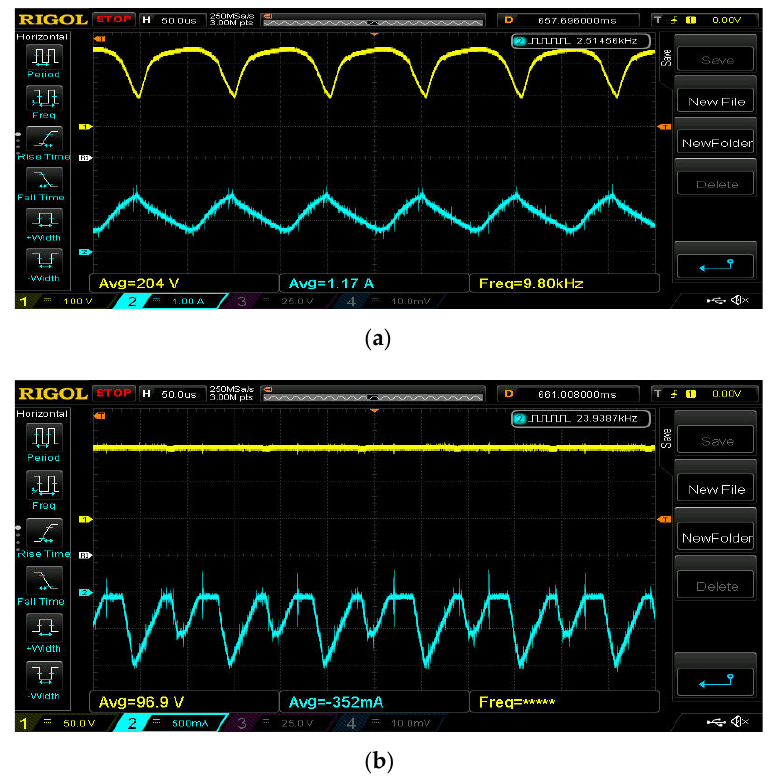
Figure 11. Experimental Wave Form of PV and Battery in ESS Least Domain.